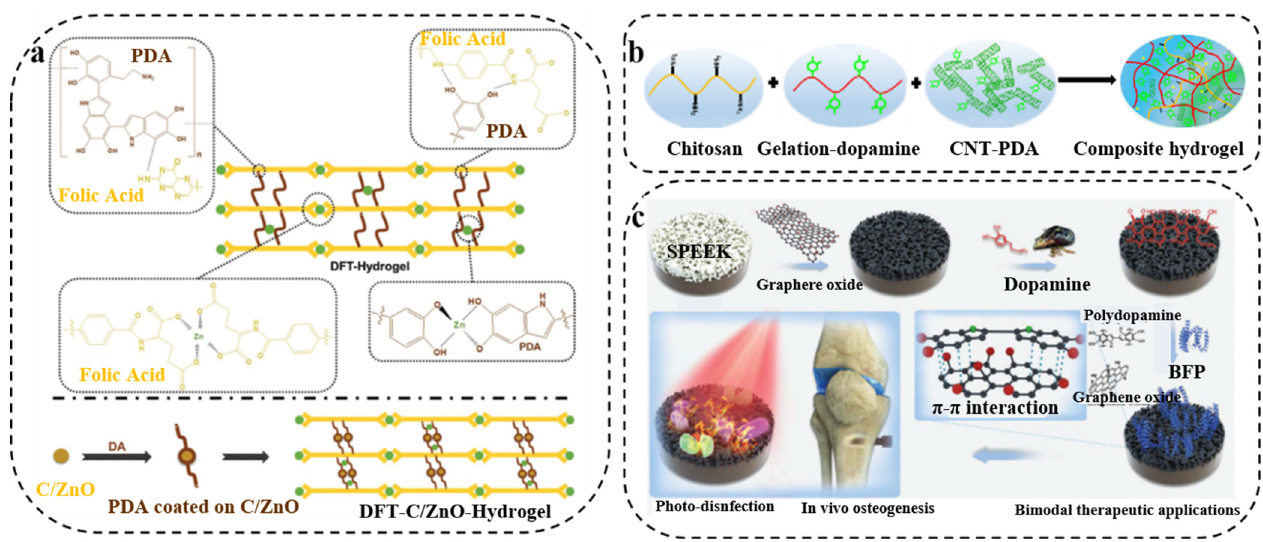
Figure 8. ( a ) Schematic of PDA-grafted nanoparticles to functionalize hydrogel. Reprinted with per- mission from [110] (copyright: Wiley-VCH, 2019). ( b ) Schematic representation of